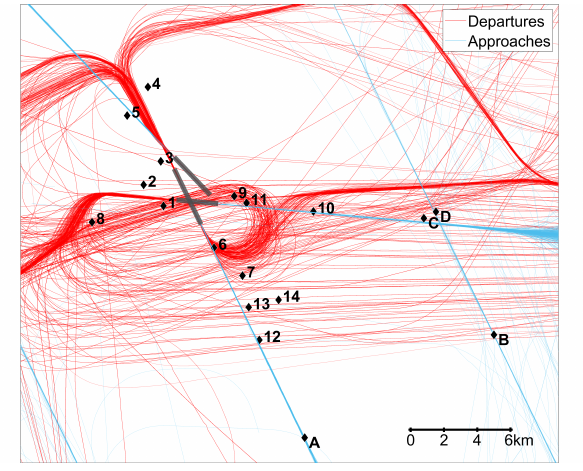
Figure 1: Measurement positions at Zurich airport (NMTs 1-14 and additional measurement points A-D) with flight